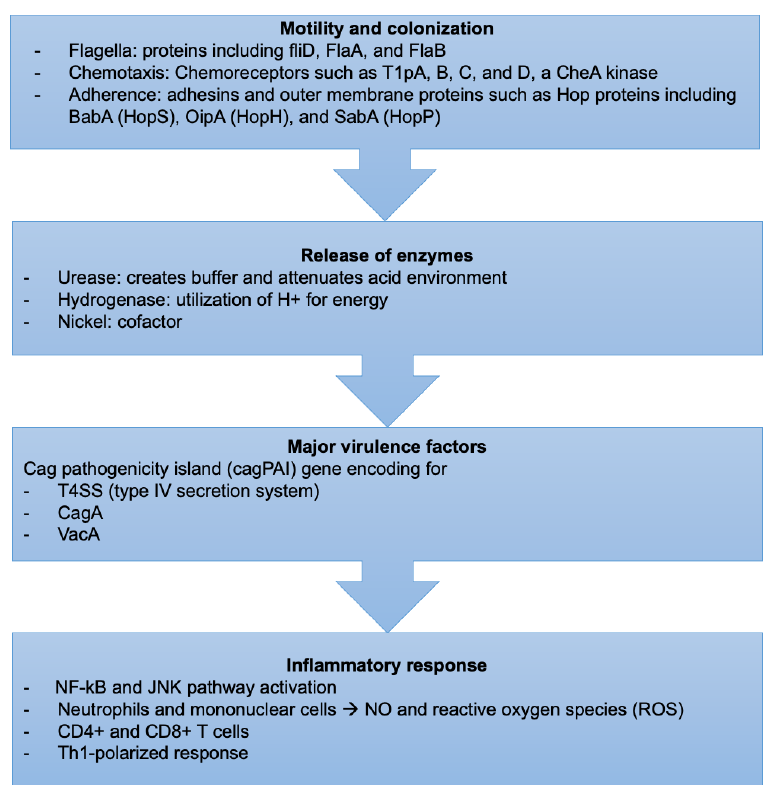
Figure 2. Sequence of events describing the virulence factors and mechanism of H. pylori infection.